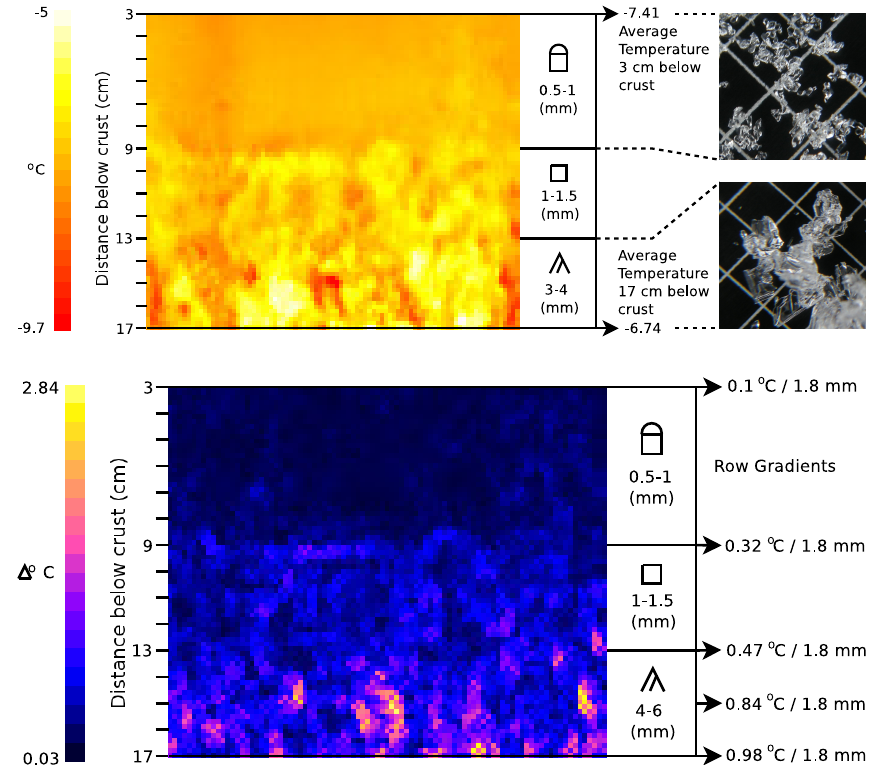
Fig. 4. Temperatures and point gradients at the leading edge of the depth hoar on 29 January 2011. The grids on the crystal screen have 3mm spacing. Crystal types are from Fierz et al.